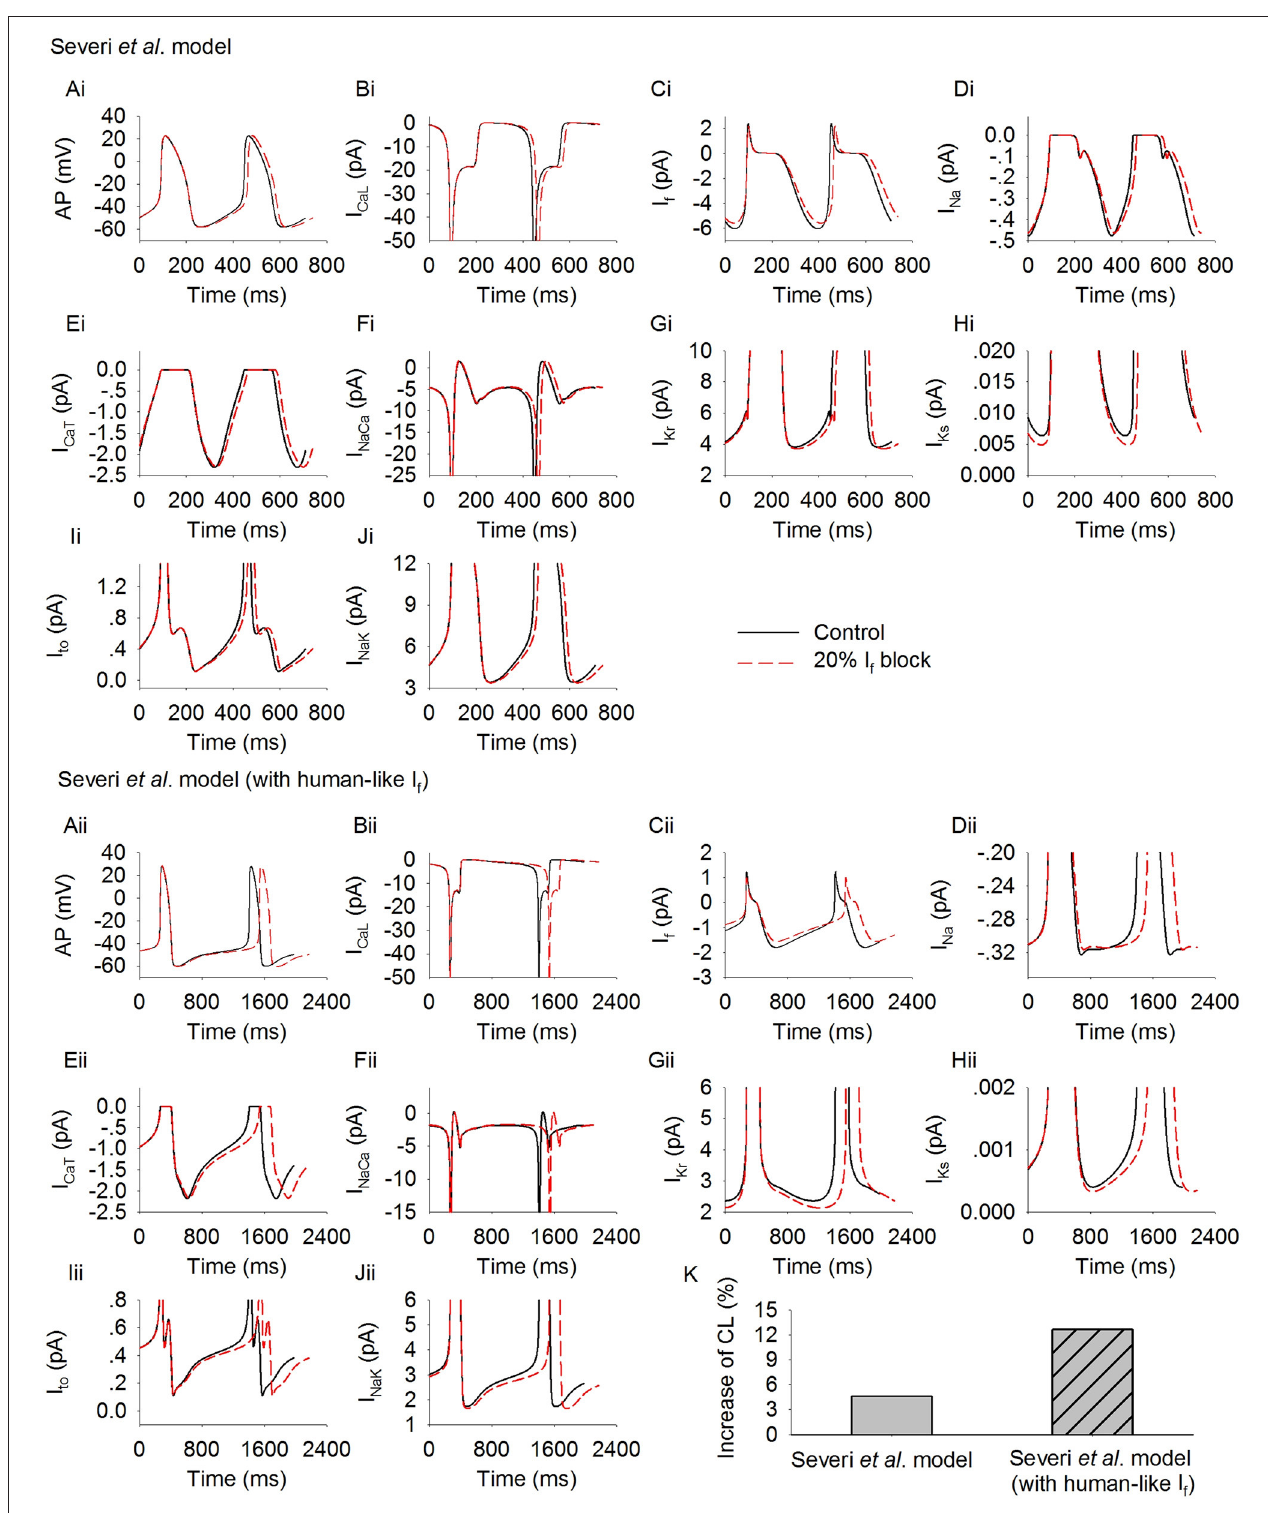
FIGURE 3 | Simulated spontaneous action potentials and underlying currents by the Severi et al. model with rabbit I f (Ai–Fi) and human I f (Aii–Fii) formulations. Effects of blocking I f by 20% on action potentials and underlying ionic currents (dotted lines) are also shown and superimposed with those in control condition (solid lines). (Ai,Aii) : action potentials; (Bi,Bii) : I CaL ; (Ci,Cii) : I f ; (Di,Dii) : I Na ; (Ei,Eii) : I CaT ; (Fi,Fii) : I NaCa ; (Gi,Gii) : I Kr ; (Hi,Hii) : I Ks ; (Ii,Iii) : I to ; (K) increase of pacing CL.